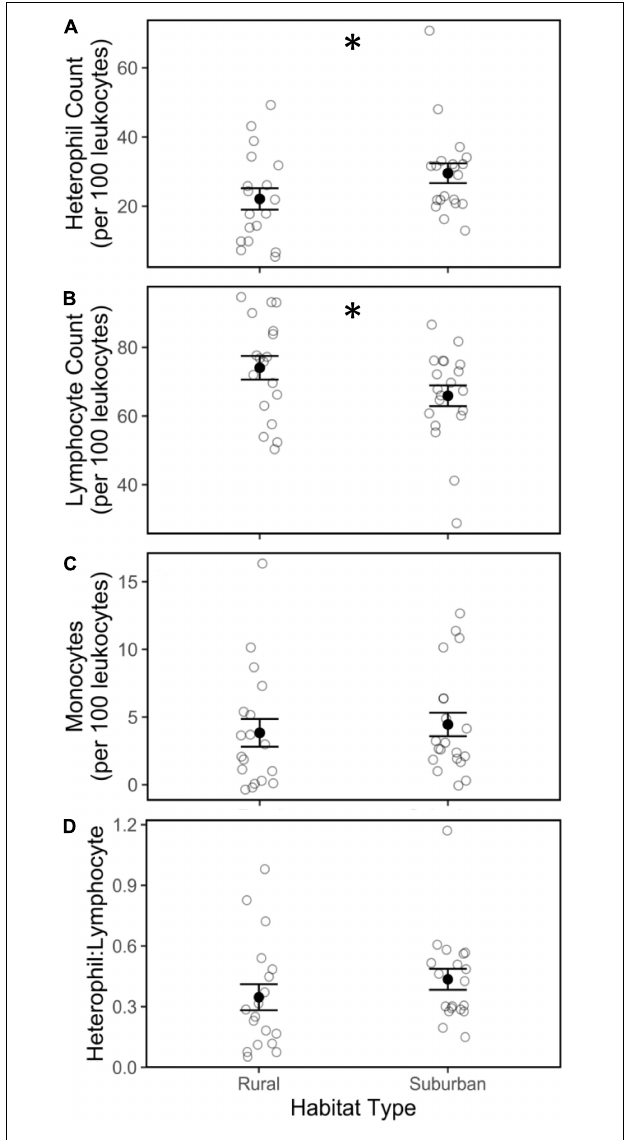
FIGURE 5 | Heterophil (A) , lymphocyte (B) , and monocyte (C) cell counts and heterophil: lymphocyte ratio (D) from male song sparrows from rural and suburban sites. Closed circles and whiskers are mean ± SE; open circles are measurements of individuals birds; asterisk denotes difference at p < 0.05.